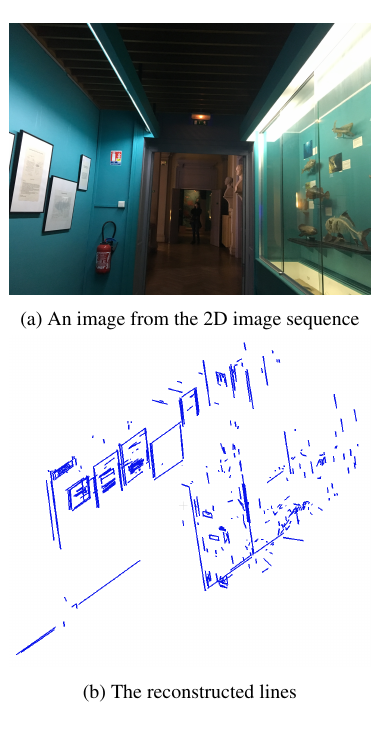
Figure 3. Reconstructed 3D line